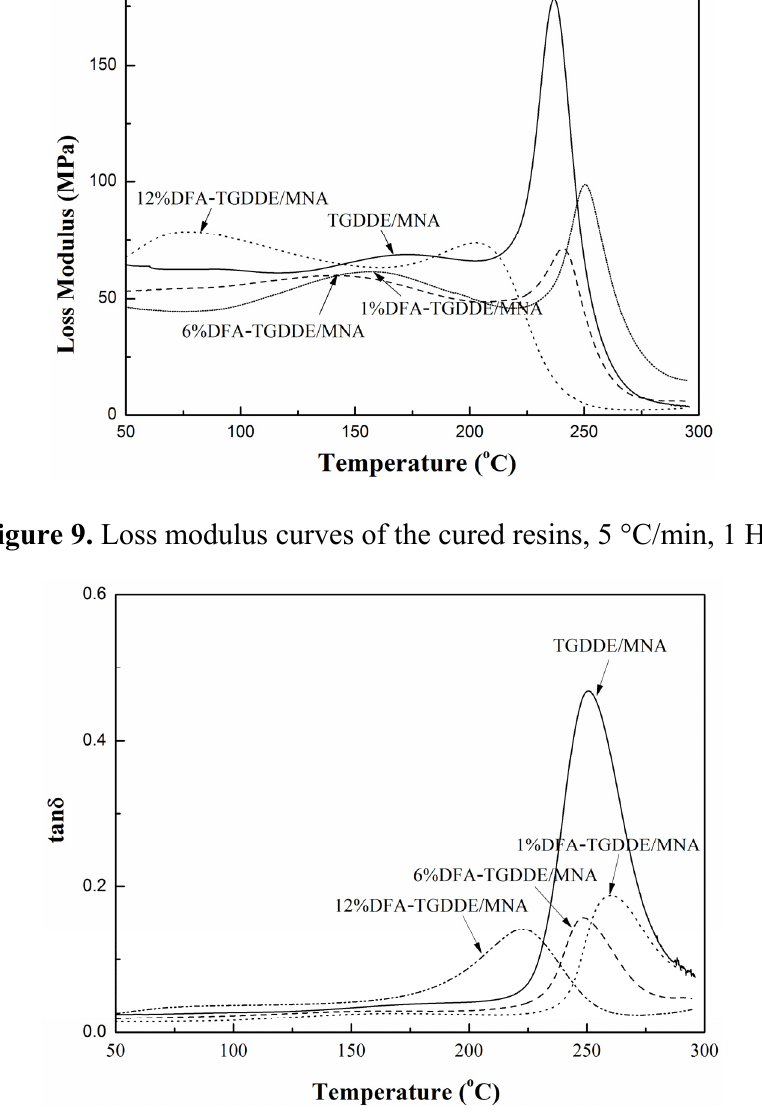
Figure 10. Tan δ curves of the cured resins, 5 °C/min, 1